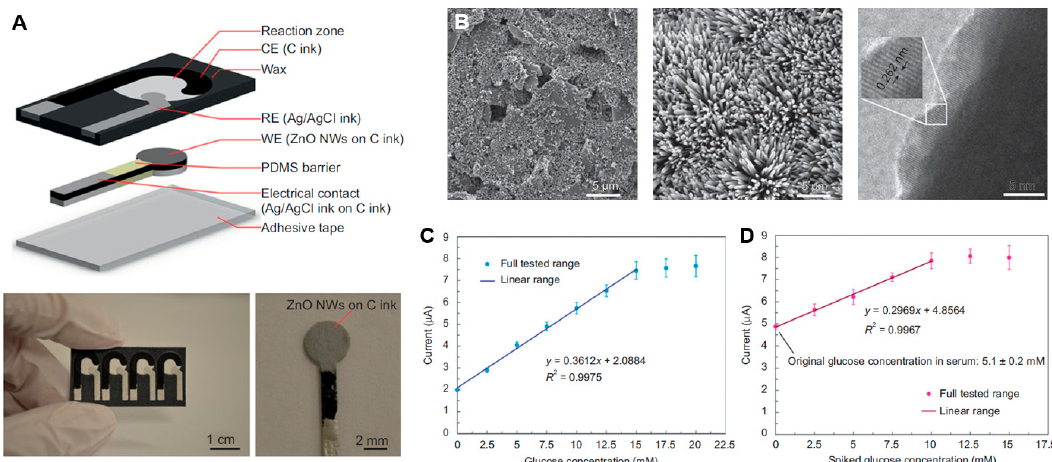
Figure 5. Integrate nanowires with disposable devices (adopted with permission from [97]). ( A ) Schematic and photograph of paper-based analytical devices (PADs) with ZnO nanowires. ( B ) Characterization of ZnO nanowires. From left to right: (1) SEM image of rough carbon surface before the growth of nanowire; (2) SEM image of nanostructured carbon surface with deposited ZnO nanowires; (3) TEM image for quantification of nanowires. ( C ) Calibration of sensor (output current vs. glucose concentration) in buffer. ( D ) Quantification of detected limits and linear range of the PADs in serum.